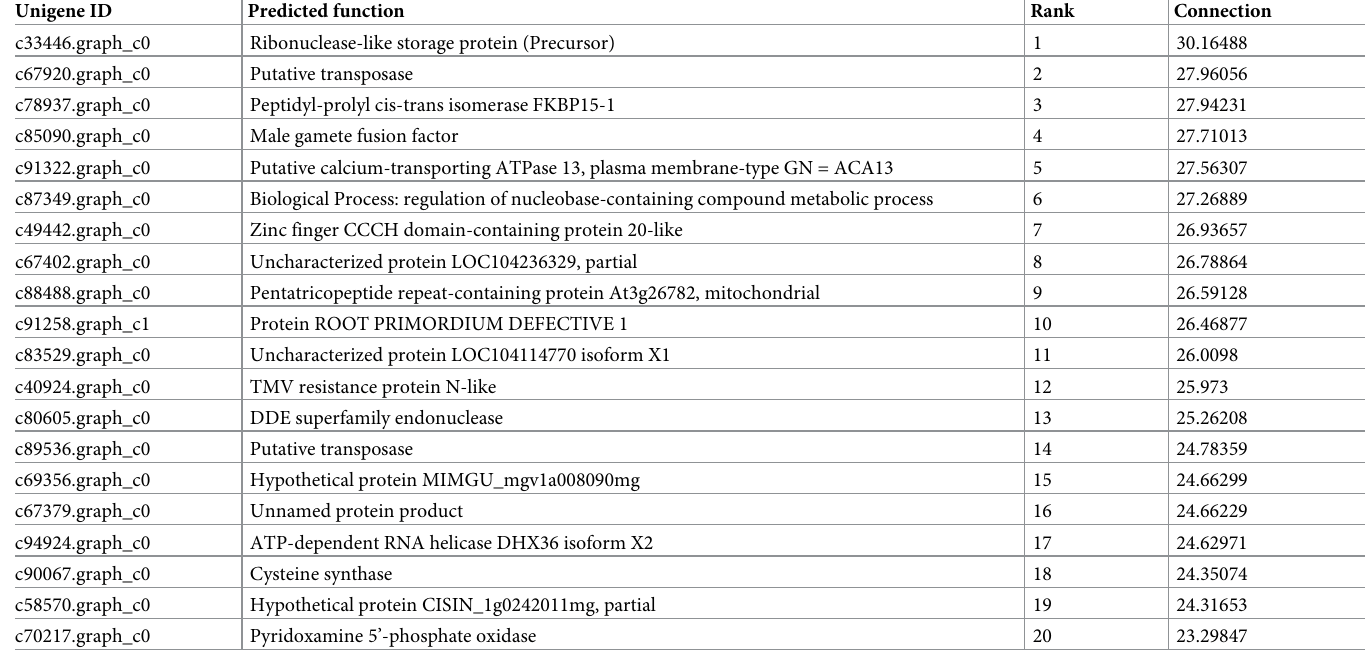
Table 6. Top 20 genes enriched in light yellow